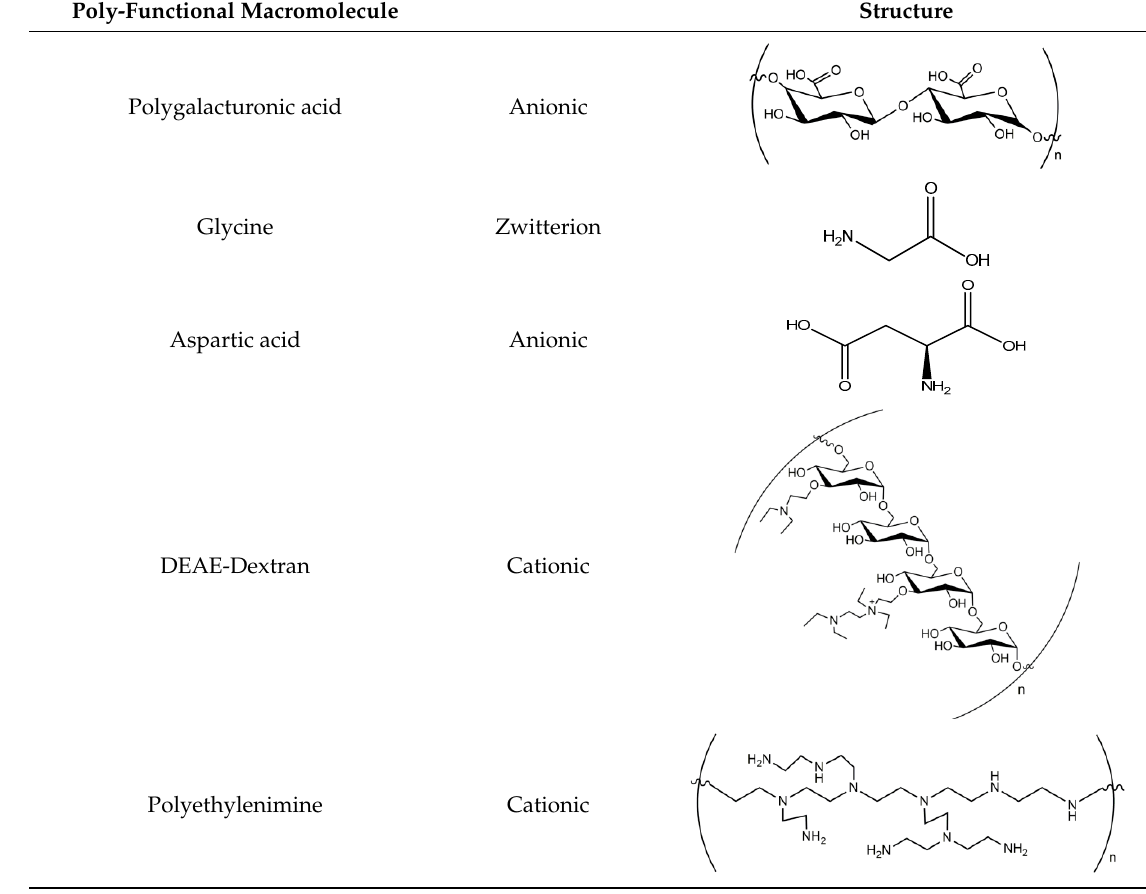
Table 3 . Time course of thermal stability of different immobilized Ea BglA derivates.